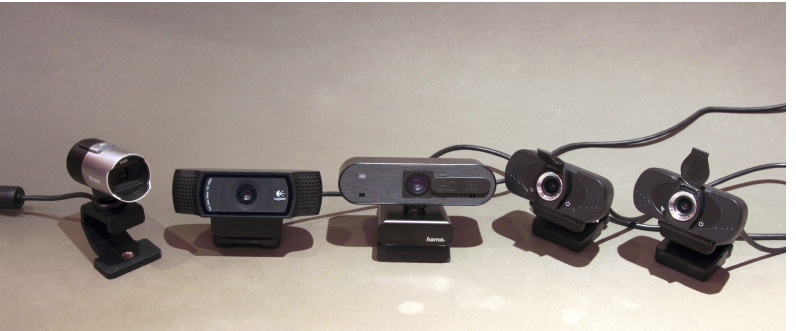
Figure 2. Cameras used in the comparison, from left to right: Microsoft LifeCam Studio (C AM -A); Logitech C920 (C AM -B); Hama C-600 Pro (C AM -C); and two Xiaomi IMILAB CMSXJ22A (C AM -D and C AM -E). Table 1. Main technical data of the cameras used in the